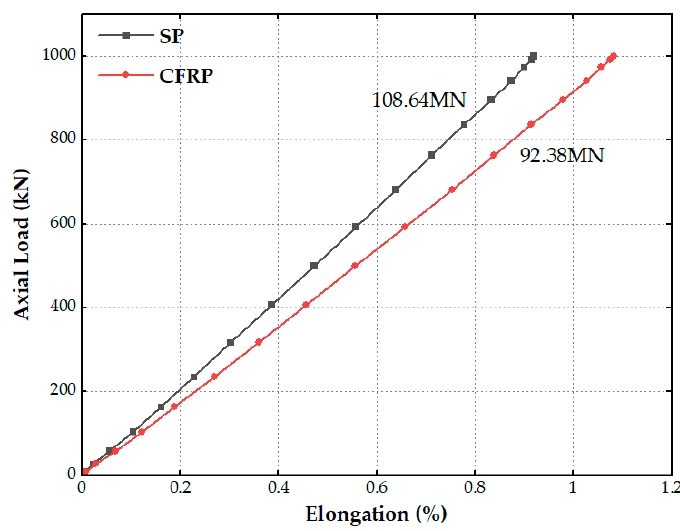
Figure 8. Tensile response of CFRP and SP.